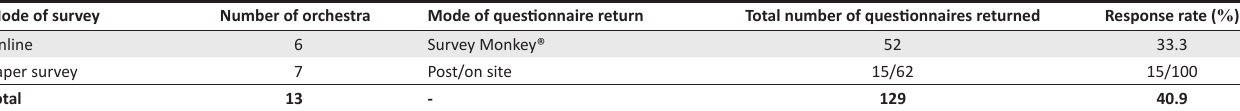
TABLE 1: Response rate of participants.